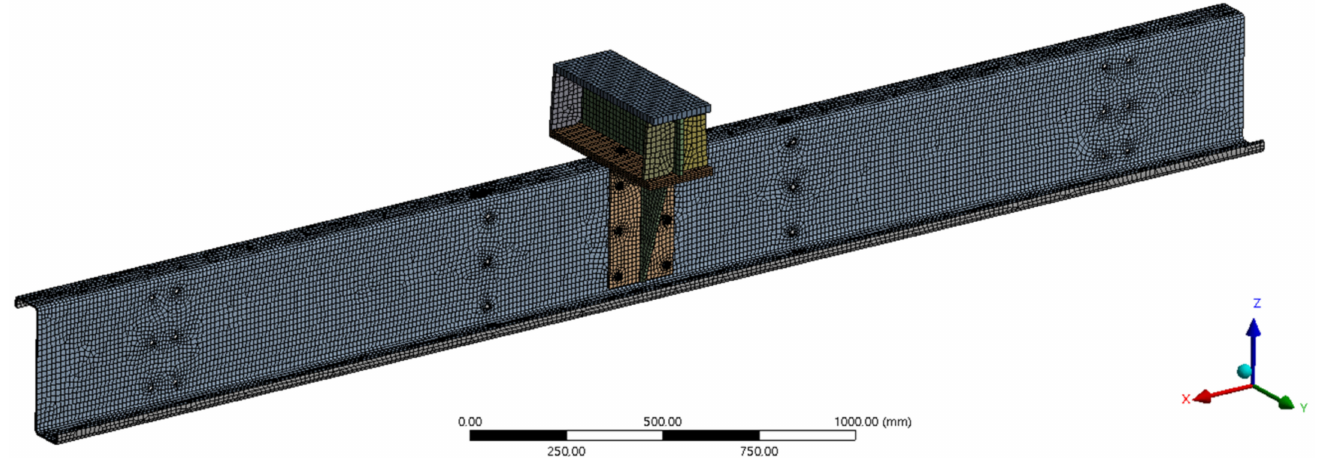
Figure 3. Experimental setup of TWCC in a hydraulic press machine.